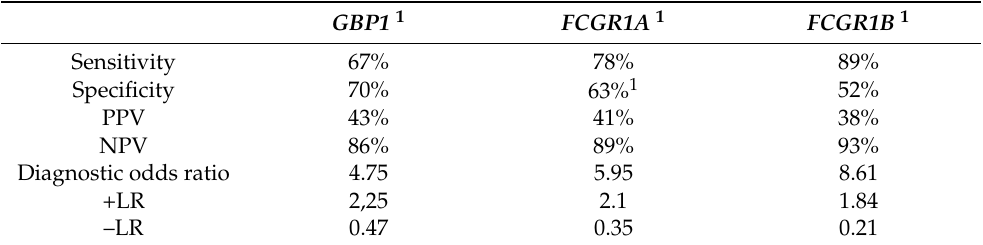
Table 6. Diagnostic values of GBP1, FCGR1A , and FCGR1B expression after two weeks of anti-TNF